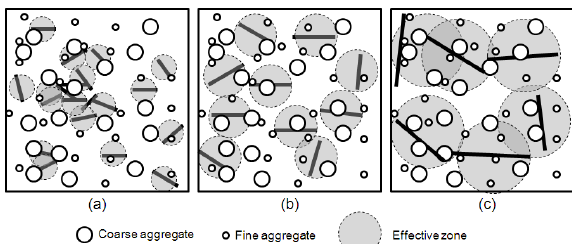
Fig. 2. Graphical illustrations of dispersion of steel fibres: a) S1; b) S2; and c) S3